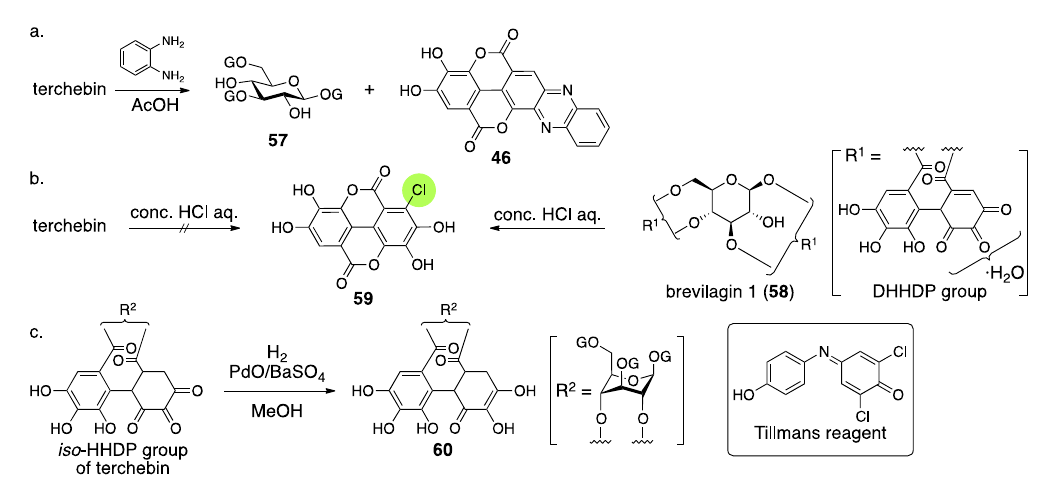
Figure 23. The transition of the structure of terchebin. The structural determination of terchebin began with degradation experiments. The treatment of terchebin with benzene-1,2-diamine and AcOH provided the known compounds 1,3,6-tri- O - galloyl- β -glucose ( 57 ) [54] and phenazine- mi 46 (Figure 24a) [55]. According to the observation that 46 was obtained in the structural determination of brevilagin 1 ( 58 ), they considered that terchebin contained the same DHHDP group bridging between O-2 and O-4 through ester bonds [55]. On the other hand, the treatment of 58 with concentrated hydrochloric acid provided chloroellagic acid ( 59 ).